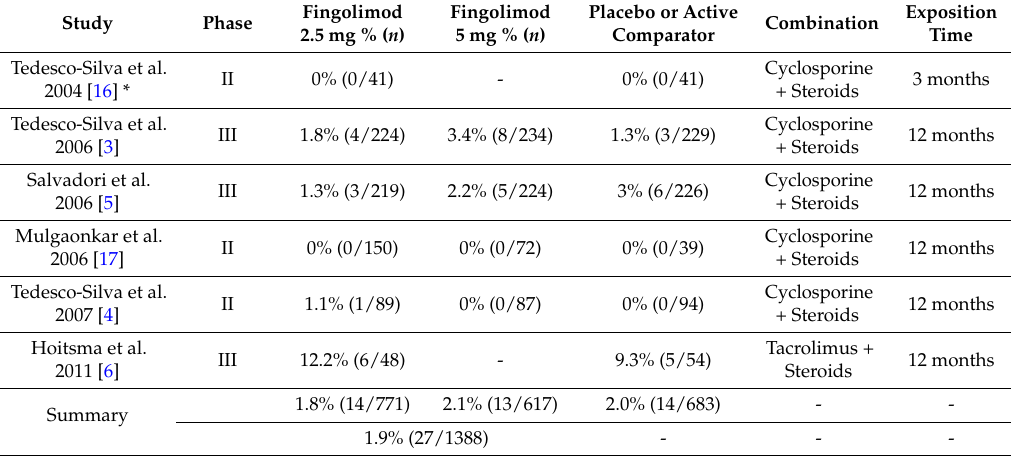
Table 1. Frequency of macular edema in clinical trials that evaluated efficacy of fingolimod in renal transplant rejection. * This study was a dose-finding study, wherein, in addition to 0.5 mg fingolimod, doses of 0.25 ( n = 43), 0.5 ( n = 43), and 1.0 mg ( n = 40) of fingolimod were also administered to study participants. No macular edema was observed at any of these